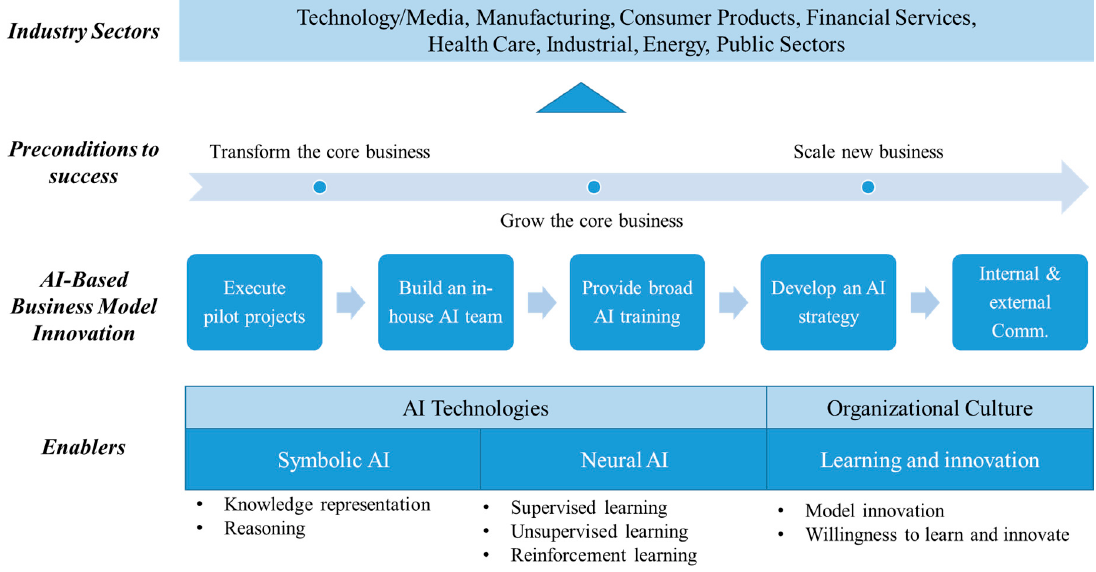
Figure 2. Developing an Artificial intelligence (AI)-Based Business Model.